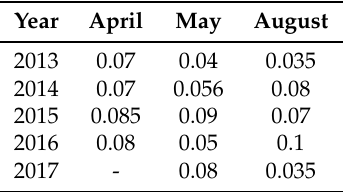
Table 2. AOD 500 thresholds to distinguish back-trajectories arriving at Zeppelin Station with high and low AOD. They are the minima in the bimodal AOD 500 distributions.